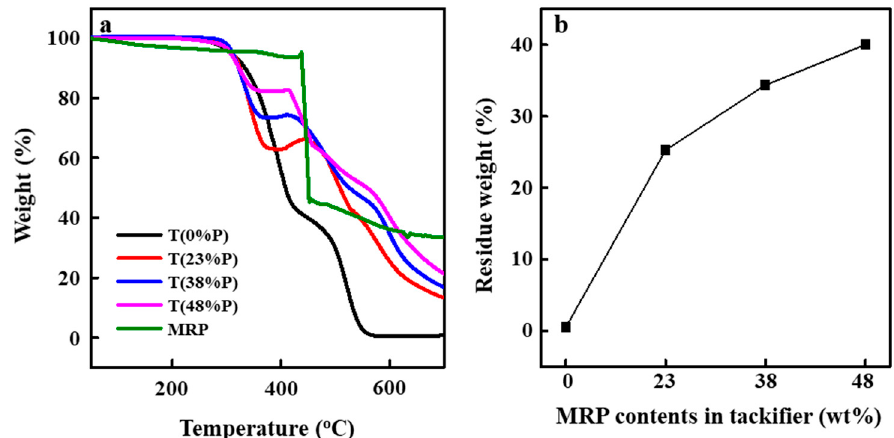
Figure 2. ( a ) Thermogravimetric registrations and ( b ) residues when heated to 600 °C under an air atmosphere for ET3228 tackifiers with MRP contents in the range of 0 to 48 wt.%.